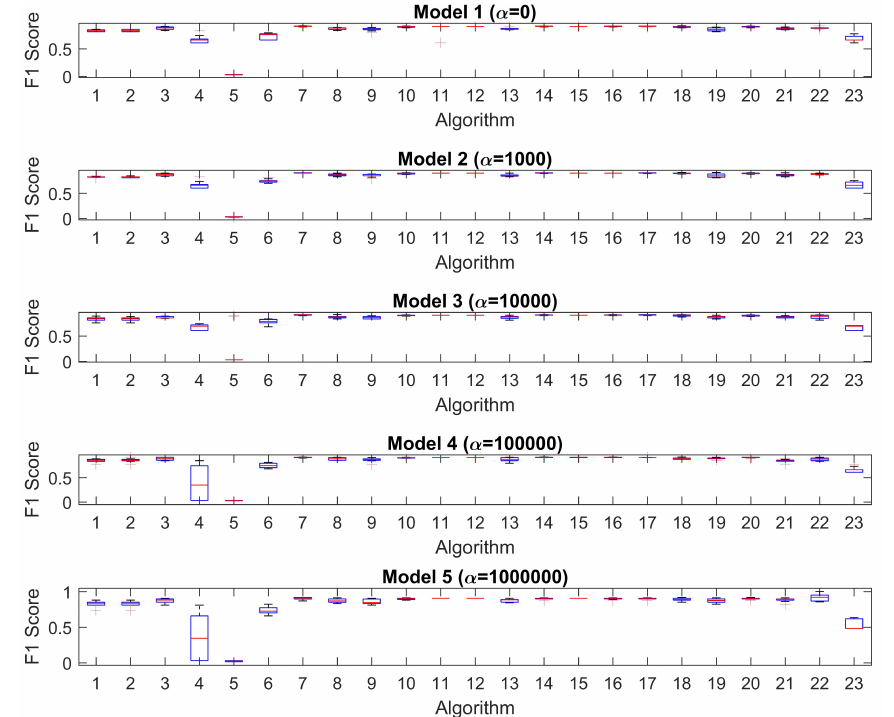
Figure A3. Numerical simulation assumption 1. F1-score of models after increasing the translation constant α for all the 23 algorithms. The 23 algorithms are represented in the x -axis, and the accuracy is shown in the y -axis.